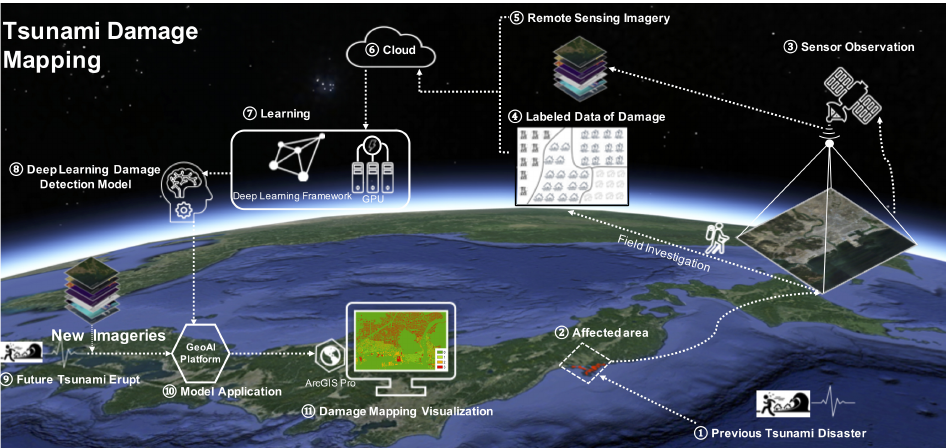
Figure 15. The pipeline of deep learning framework for detecting tsunami